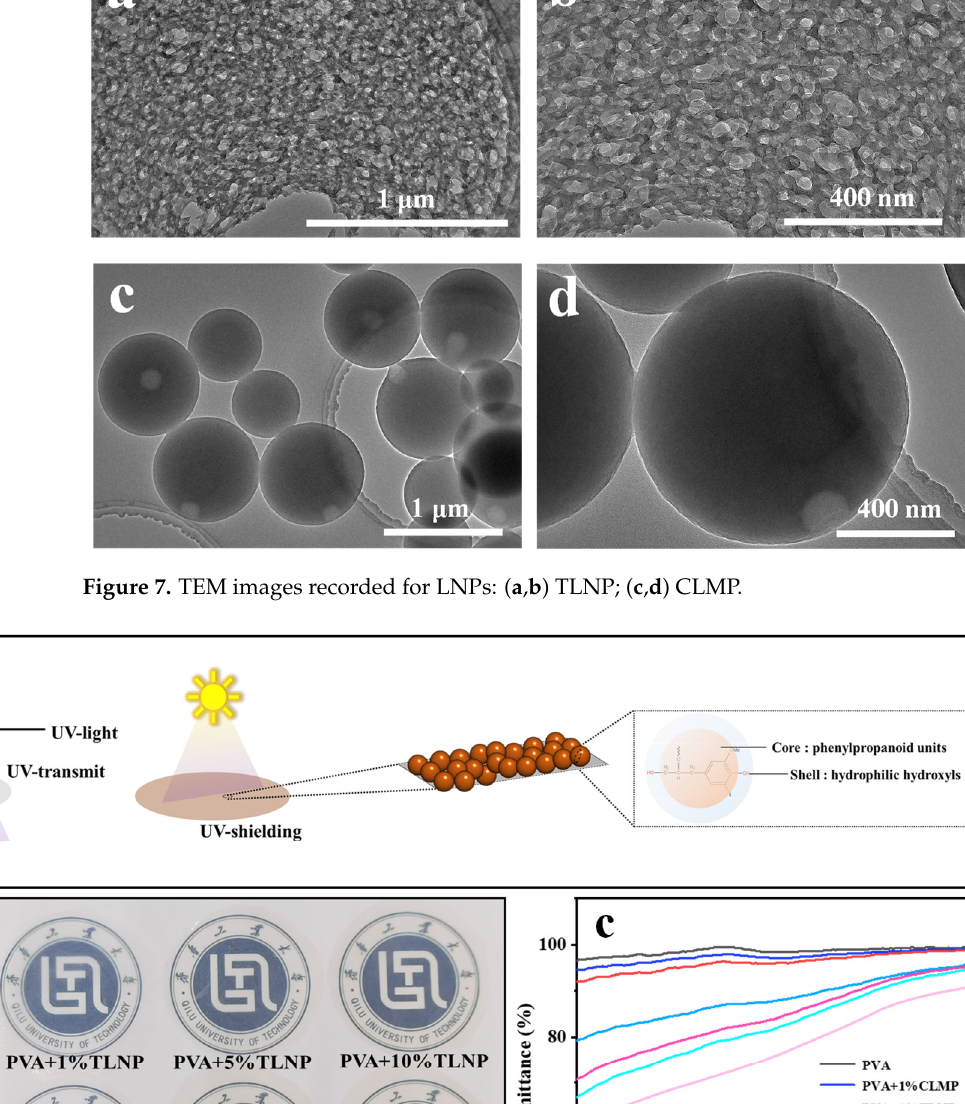
Figure 6. Lignin condensation facilitates solution-based self-assembly for the production of spheri- cal lignin nanoparticles.